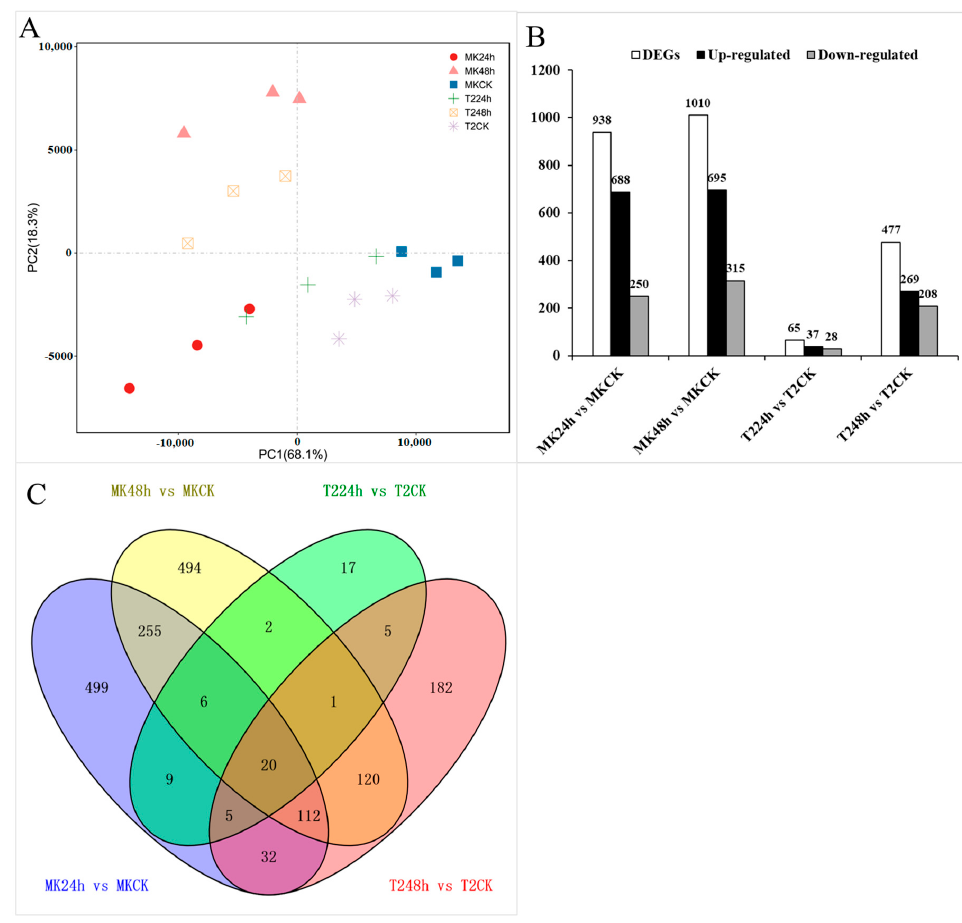
Figure 3. Transcriptomes of plants under TYLCV infection. ( A ) Principal component analysis (PCA) of the RNA sequencing data. The 18 samples (three biological replicates of CK (0), 24, and 48 h) were projected on the first and second principal components (PCs). PC1 and PC2 account for > 86% of the total variance in the data. ( B ) Numbers of differentially expressed genes (DEGs). ( C ) Venn diagram depicting the number of all DEGs expressed in the leaves of MK and T2 under TYLCV infection and control